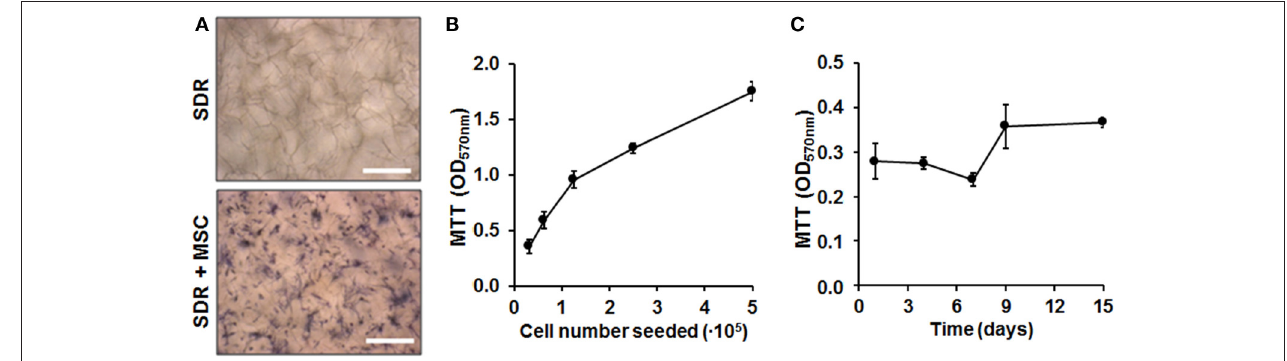
FIGURE 2 | Cell load capacity and cellular viability within SDR matrices. (A) MTT assay on empty- and MSC-containing SDR matrix demonstrates specific formazan formation by cells (dark blue). (B) MSC were seeded in 0.13cm 2 pieces of SDR matrix and cultured for 24h to allow maximum spreading and adhesion of cells. Then, scaffolds with cells were incubated with MTT substrate to determine relative cellularity based on formazan blue formation. (C) MSC in SDR matrices shows relatively constant MTT hydrolysis for up to 15 days. Scale bars represent 200 µ m.